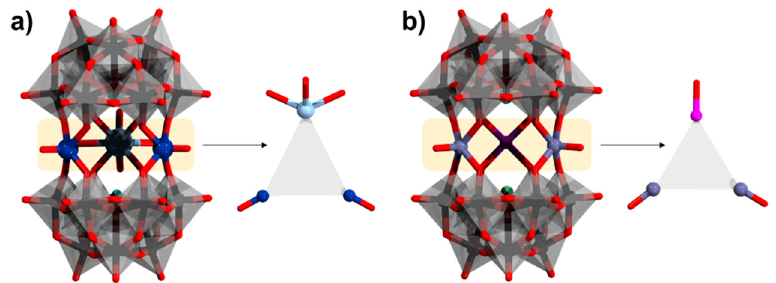
Color code: As = green, Ti = dark pink, Co = violet, V = dark blue, Gd = light blue, {WO 6 } = gray octahedra, W = black, and O = red. H atoms on aqua ligands are